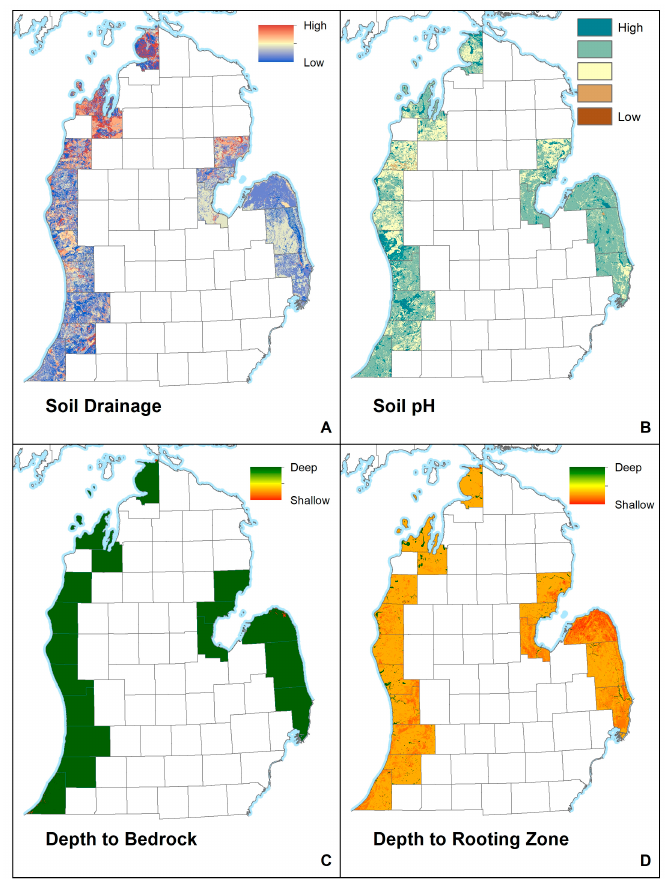
Figure 3. Spatial patterns of the four soil variables analyzed in the models including: soil drainage as dictated by ( A ) soil composition, ( B ) soil pH, ( C ) depth to bedrock, and ( D ) depth of the rooting zone.